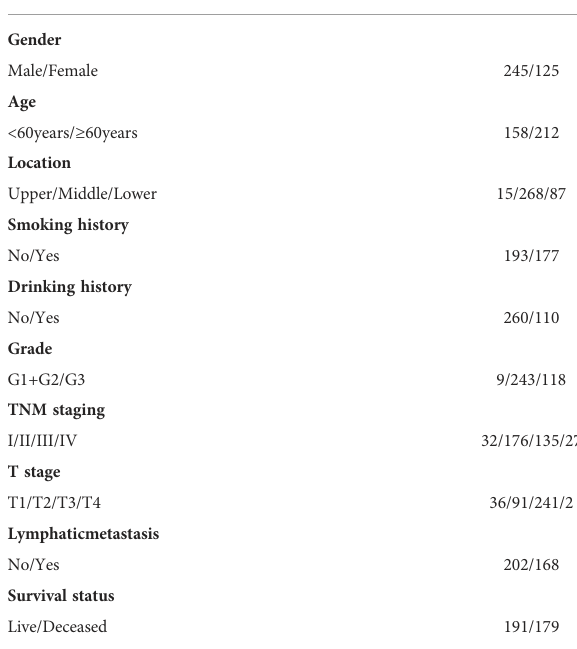
TABLE 1 The clinical characteristics of ESCC